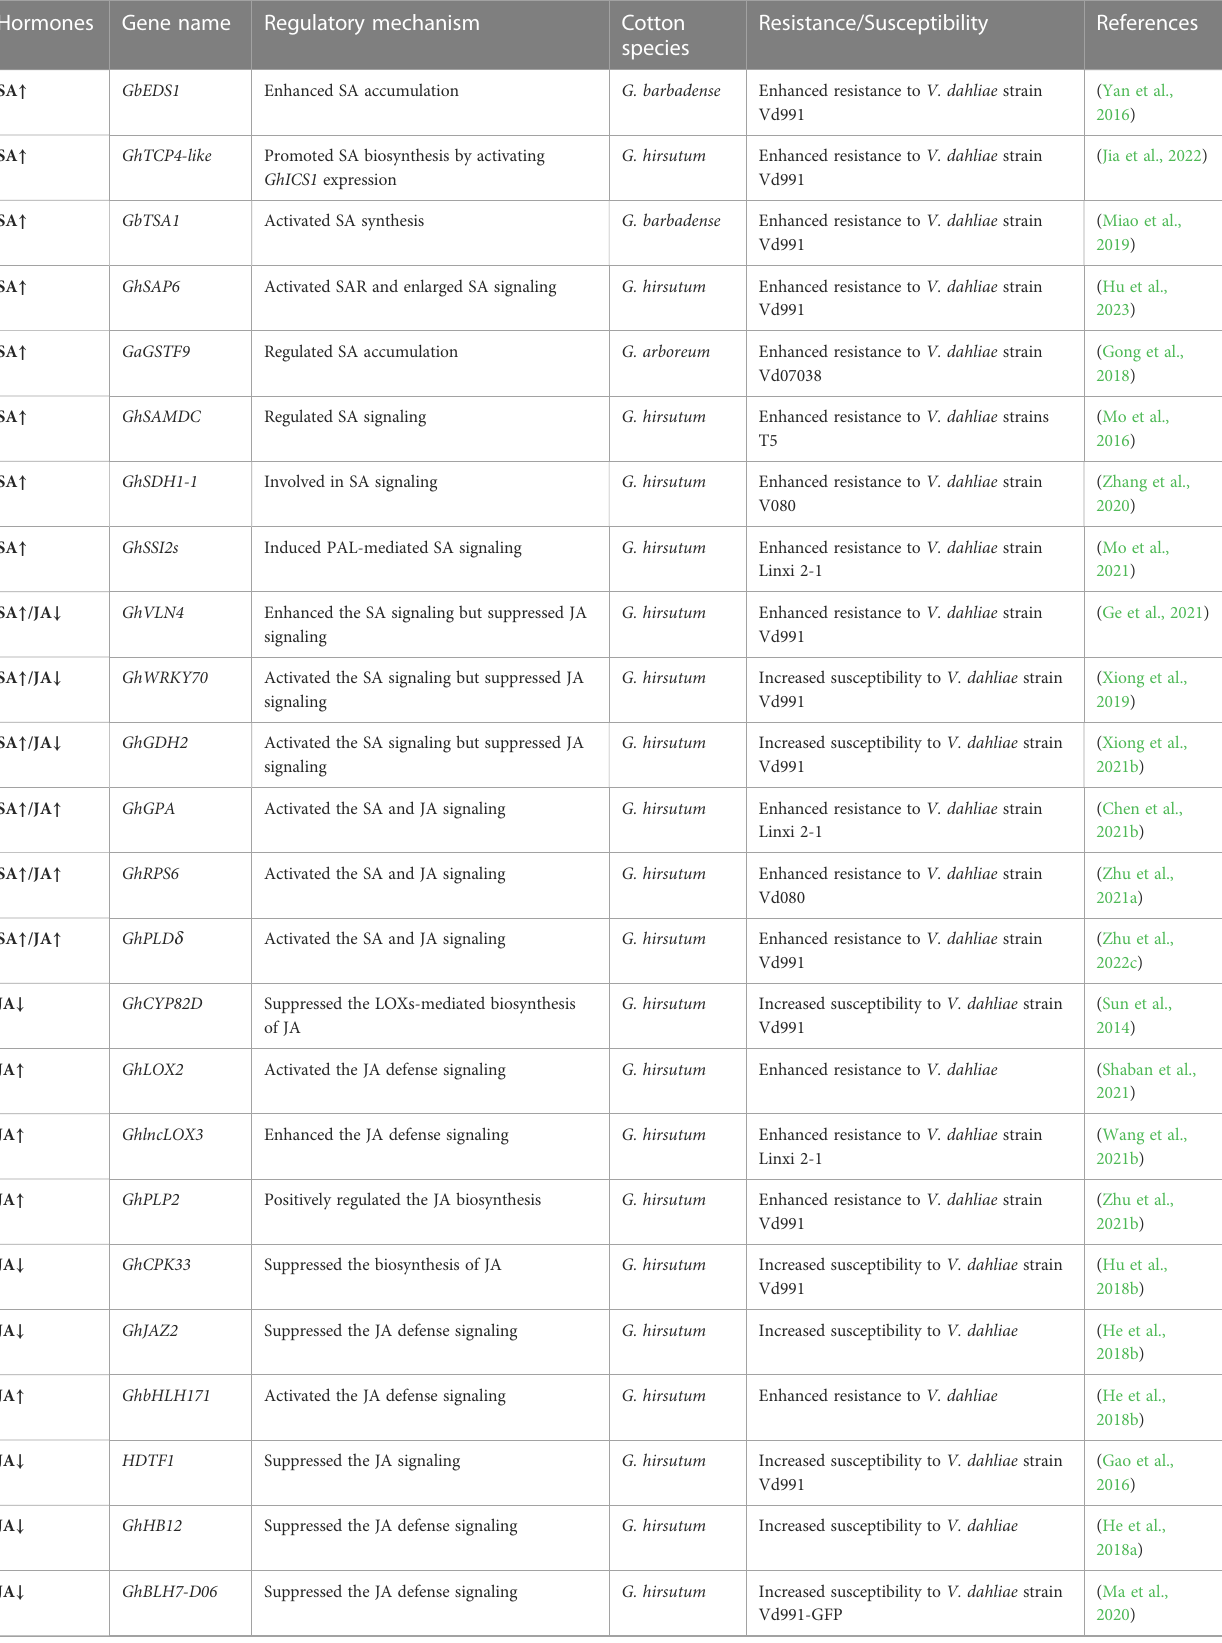
TABLE 1 Genes implicated in the SA, JA, and Eth defense signaling in response to V. dahliae